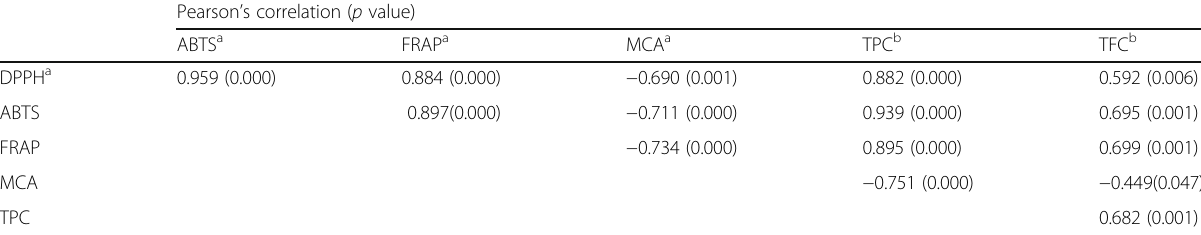
Table 4 The correlation analysis of total antioxidant capacities and main active ingredients of water extracts prepared from 20 polyherbal medicines used as